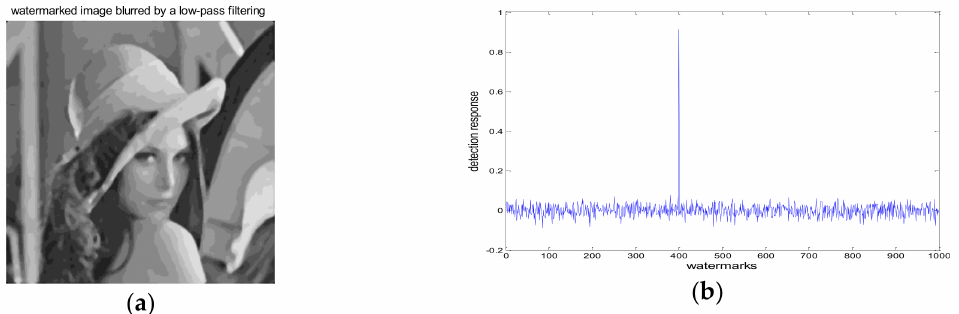
Figure 5. ( a ) Low-pass filtering attack; ( b ) detector response.